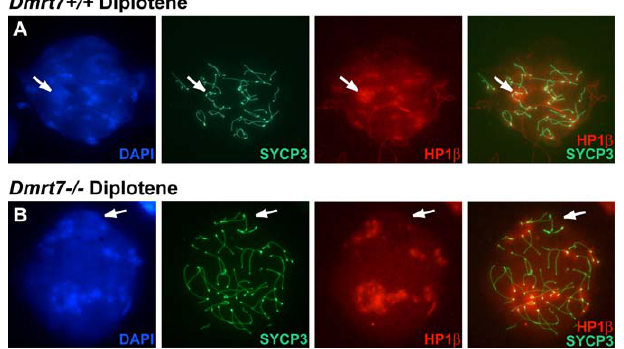
Figure 9. Abnormal Sex Chromatin in Cells Staged by Chromosome Pairing Status (A) Spread of wild-type germ cell stained with DAPI, anti-SYCP3, and anti- HP1 b showing chromosome morphology typical of diplonema and internalized XY body with HP1 b accumulation. (B) Spread of Dmrt7 mutant germ cell showing normal diplotene chromosome morphology and internalized XY body, but no HP1 b accumulation in the XY body. XY chromosome pairs are indicated by arrow.